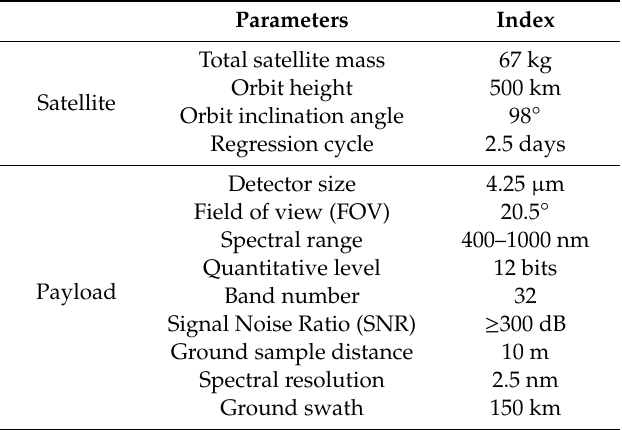
Figure 3. Spectral response functions of OHS hyperspectral bands. Table 1. Orbita hyperspectral satellite (OHS) and payload parameters.